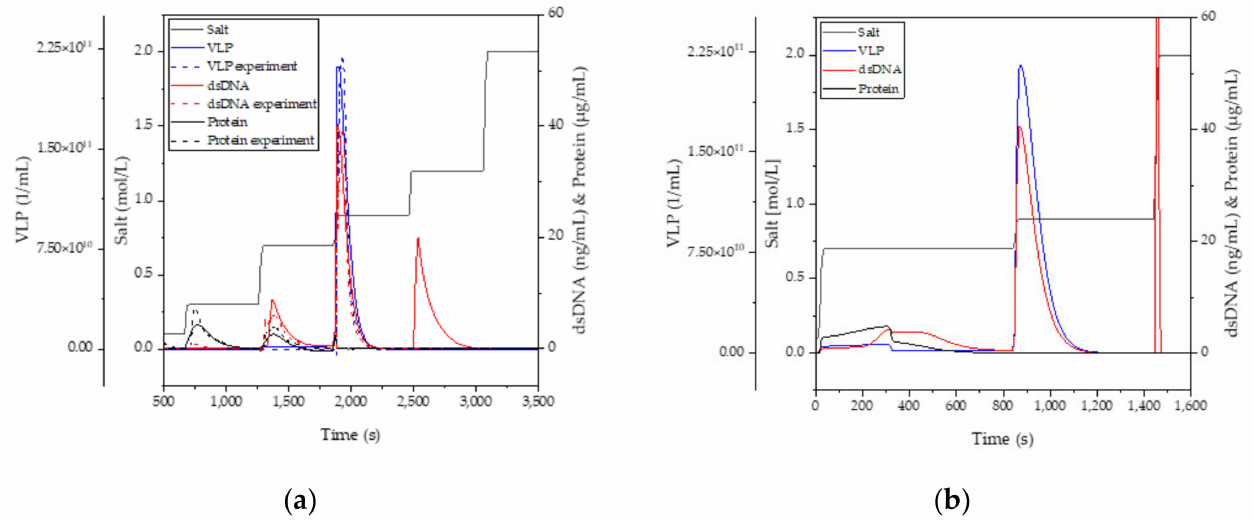
Figure 10. Results of the parameter determination ( a ). Dashed lines are the experimental results; solid lines are the digital twin results. In ( b ), the results for a potential optimized and scaled-up capture step are